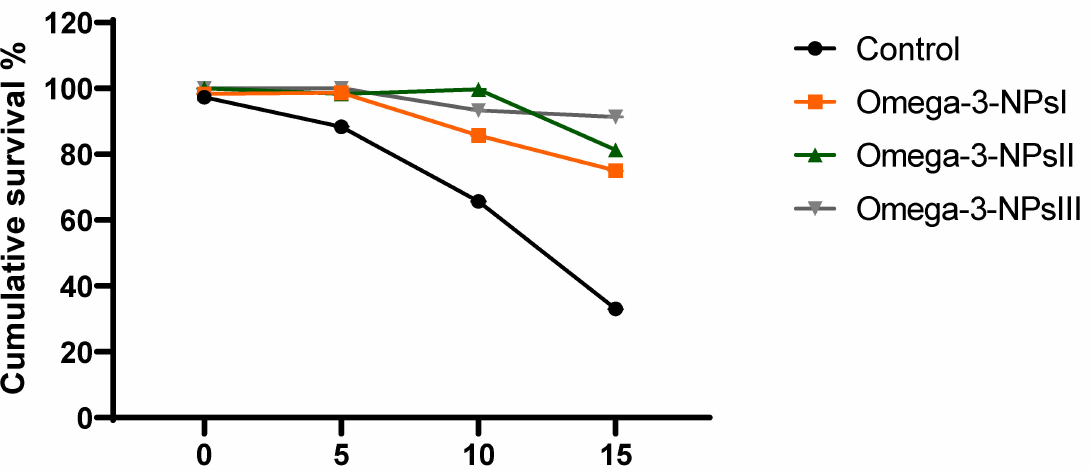
Figure 6. Effect of diets enriched with different supplemental levels of omega-3NPs (omega-3 nano particles) on cumulative survival percent in Nile tilapia after challenge with Aeromonas hydrophila . Control: basal diet without omega-3-NPs omega-3-NPsI, II, and III: basal diet supplemented with omega-3-NPs at levels of 1, 2, and 3 mg/kg diet,